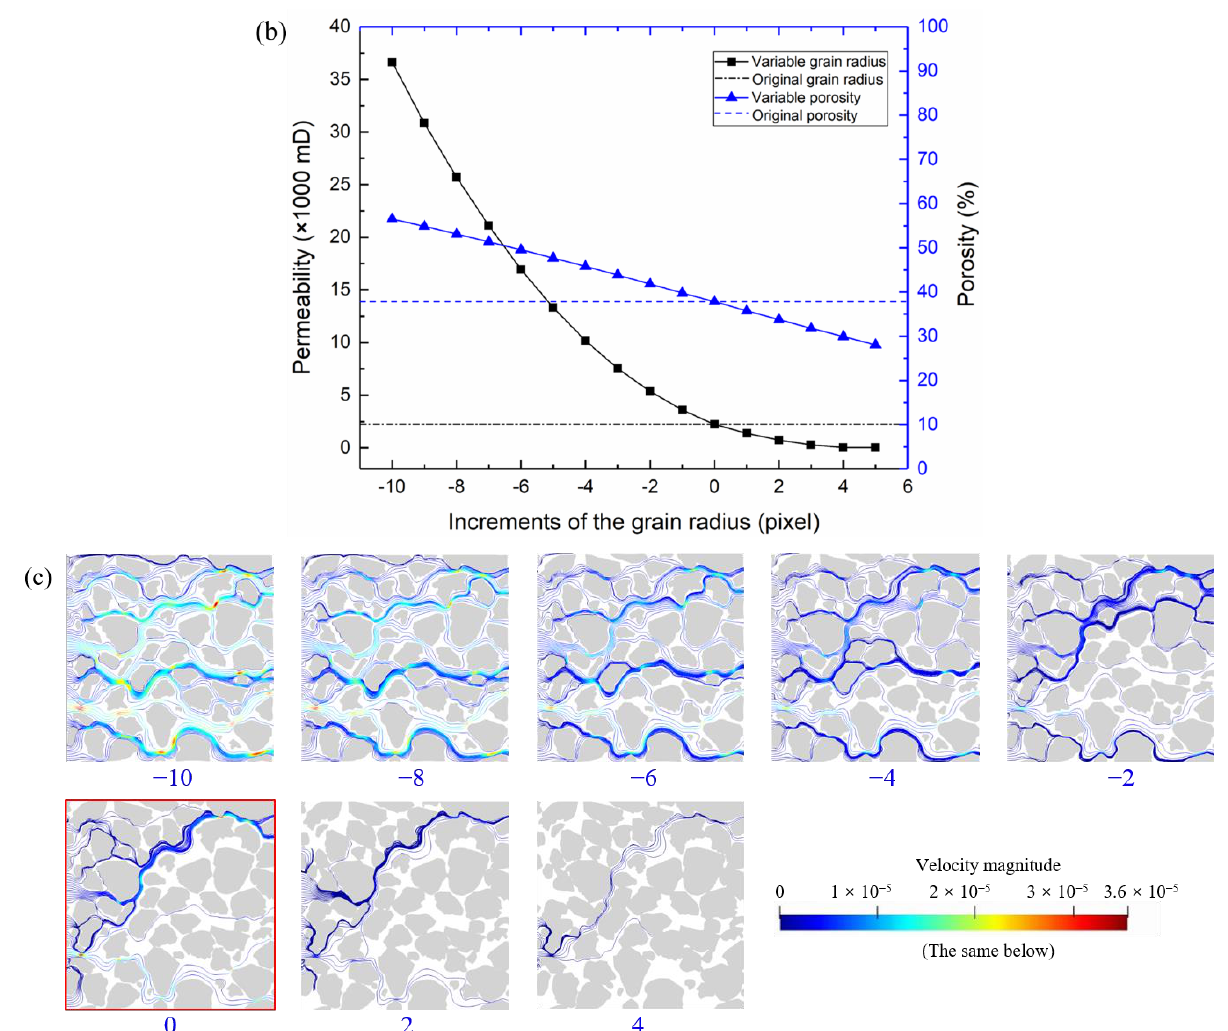
Figure 13. Influence of grain radius on permeability. ( a ) Pore models with different grain radiuses; ( b ) porosity and permeability of pore models with different grain radiuses; ( c ) flow paths and velocity of pore models with different grain radiuses.